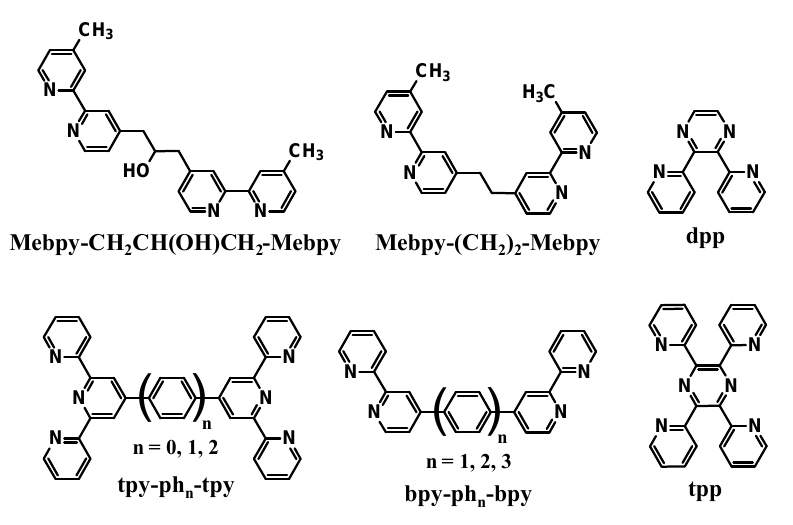
Figure 2. Polyazine bridging ligands.